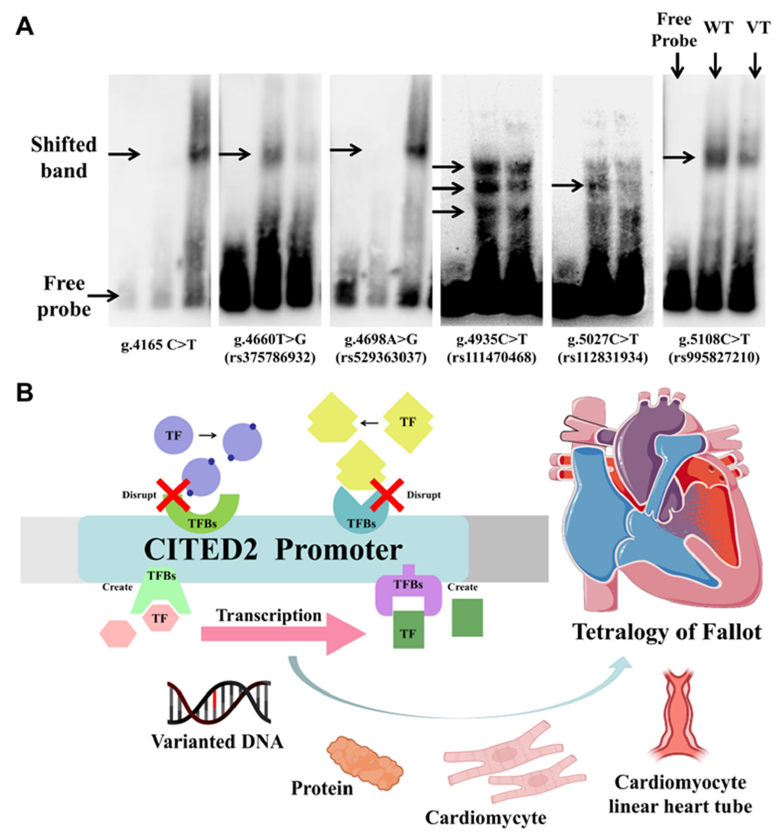
Figure 4. Electrophoretic mobility shift analysis (EMSA) experiments and schema on the effects of variants in the CITED2 promoter region on possible pathways in cardiac development. ( A ) Experimental results of electrophoretic mobility shift analysis of CITED2 gene promoter variants. Free probes are marked at the bottom; arrows indicate affected binding of unknown transcription factors (TFs); WT, wild type; VT, variant. ( B ) Effect of variants in the CITED2 promoter region on some TFs and the possible consequence of cardiac development.